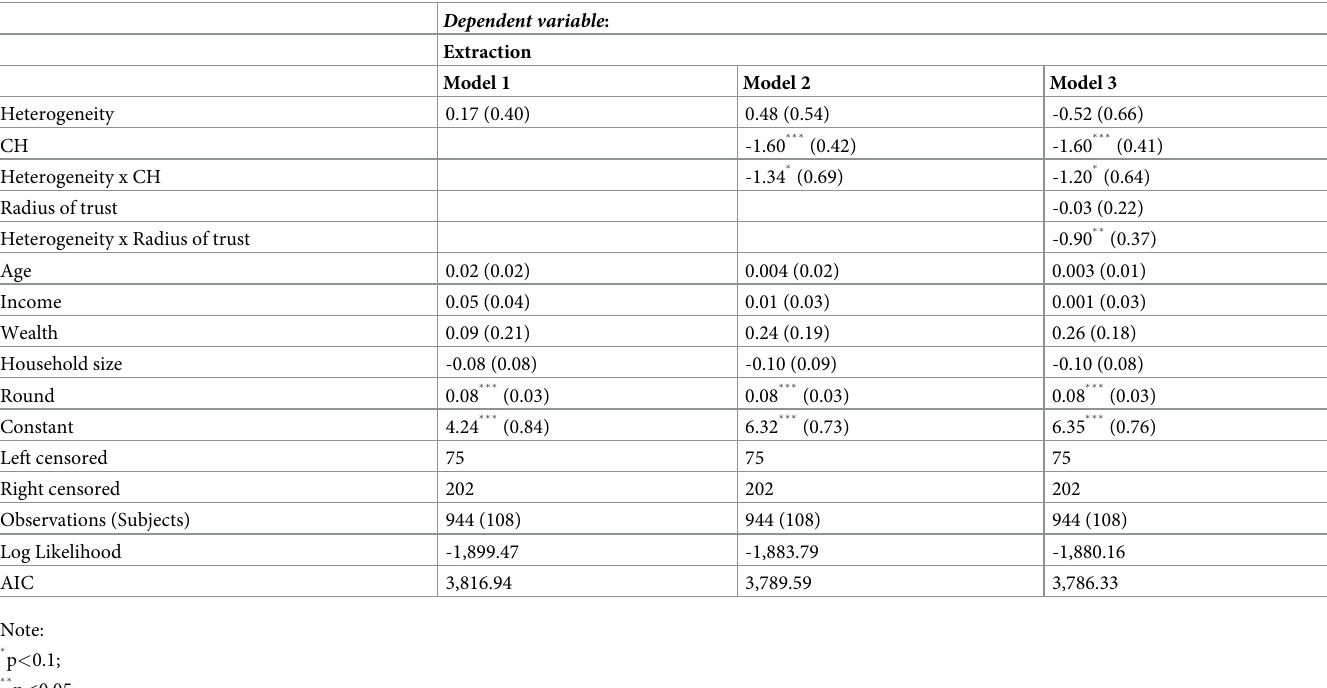
Table 3. Tobit panel regressions on CPR experimental behaviour, including demographic (age, income, wealth, household size) and a dynamic controls for round. Dependent variable